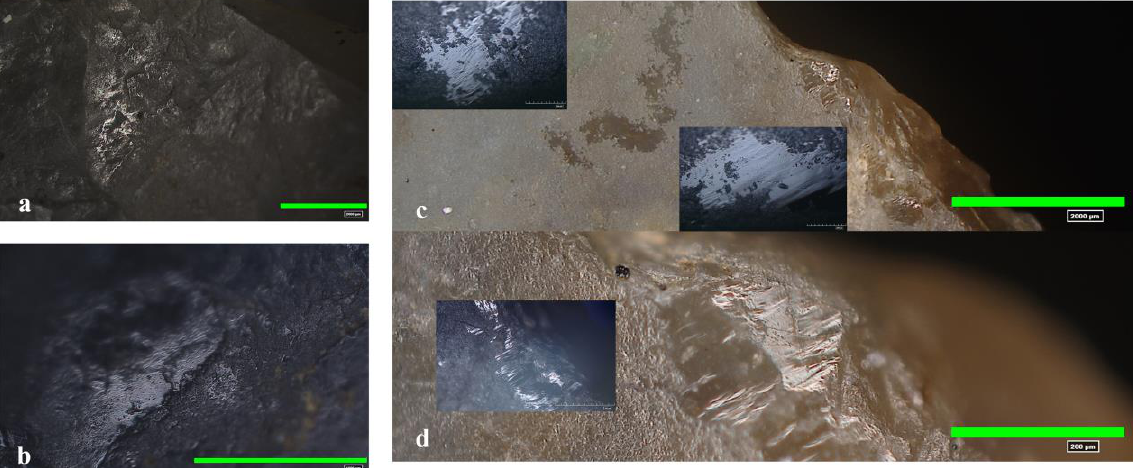
Figure 17. Trench C, sample 36: a) flake, scale bar equal to 2000 μm b) flake, scale bar equal to 1000 μm; Slope 1, sample 24: c) presence of bright spots, scale bar equal to 2000 μm d) presence of bright spots with and without striations, scale bar equal to 200 μm. Details of bright spots on c) and d) have scale bars equal to 200